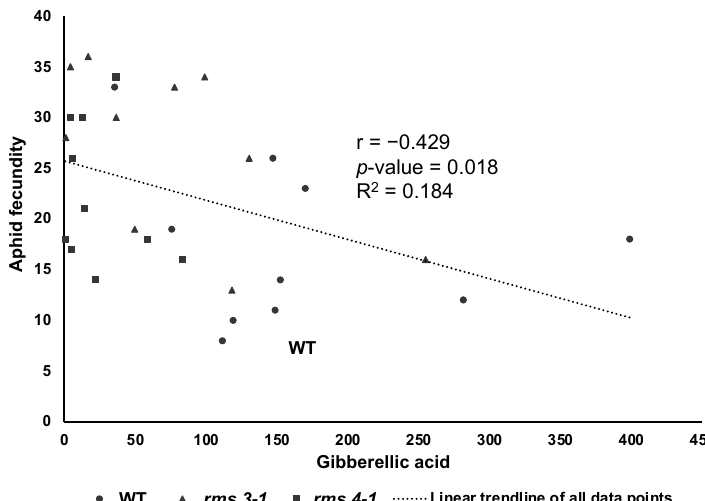
Figure 7. The number of aphids on each plant was significantly correlated ( p = 0.018) with shoot gibberellic acid concentration (ng/g DW) with a single relationship explaining variation across all genotypes ( n = 30, n = 10 per genotype).